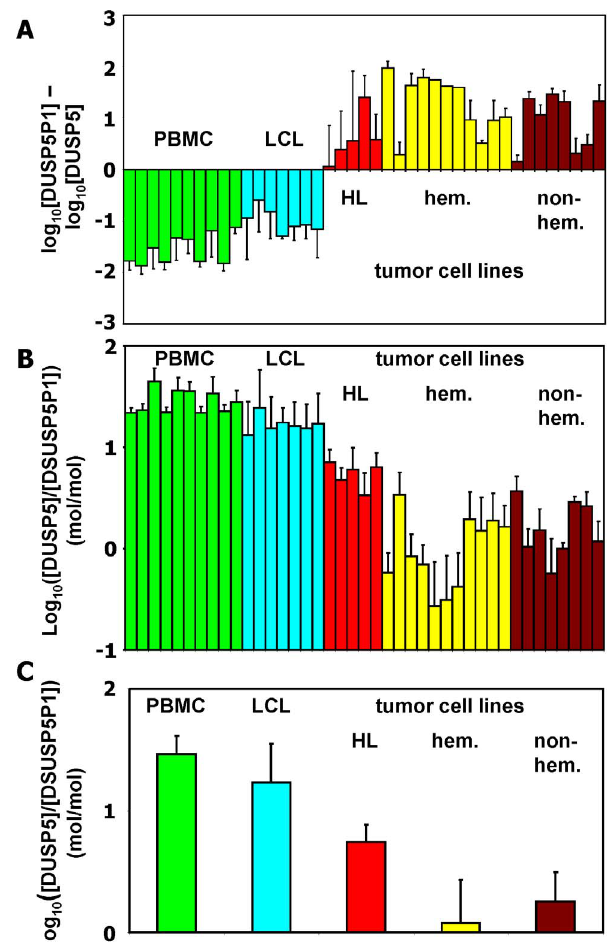
Figure 6. The ratio of DUSP5 and DUSP5P1 discriminates between malignant and non-malignant cells. Quantitative RT-PCR was used for determination of expression of DUSP5 and DUSP5P1 in cell lines and normal PBMC. (A) For calculation of relative expression values, GAPDH was used as housekeeping control and the mean D ct value was set as 1. Presented are the DUSP5P1/DUSP5 ratios in the indicated samples (from left to right: 10 PBMC, 7 EBV immortalized B cell lines (LCL), 5 HL cell lines (L-1236, L-428, L-540, KM-H2, HDLM-2), hematopoietic (hem.) tumor cell lines (Daudi, Raji, Jurkat, THP-1, 697, cALL2, NALM-6, Kasumi, K562, HL-60, U937), 4 neuroblastoma cell lines (SiMa, Kelly, SH-Sy5y, CHP-134), 4 Ewing sarcoma cell lines (SK-N-MC, A673, RD-ES, TC71). (B) Absolute copy numbers of DUSP5 and DUSP5P1 were calculated based on the vector titrations (see Figure S1). Presented are the DUSP5/DUSP5P1 copy numbers ratios (means and standard deviations) in the indicated samples (same samples as in panel A). (C) Absolute copy numbers of DUSP5 and DUSP5P1 were calculated based on the vector titrations. Presented are the DUSP5/DUSP5P1 copy numbers ratios (means and standard deviations) of in the indicated sample groups. With the exception of the difference between hematopoietic and non-hematopoietic tumor cells, all other differences are statistically significant (non-malignant vs malignant: p , 10 2 10 ; non- malignant vs. HL: p , 10 2 8 ; Student’s